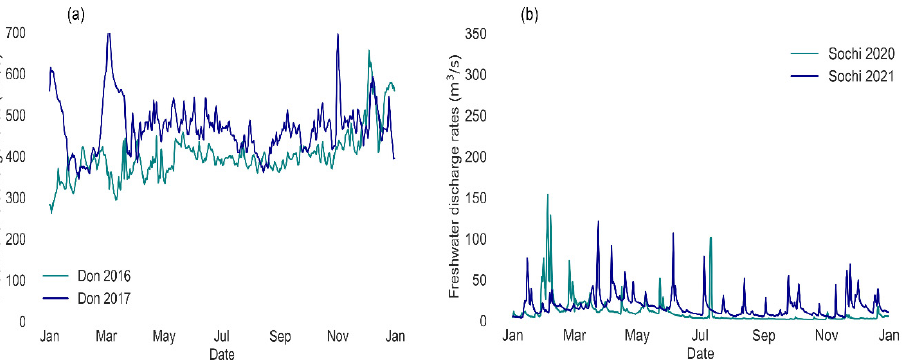
Figure 11. Freshwater discharge rates of the Don River during 2016–2017 ( a ) and Sochi River during 2020–2021 ( b ).